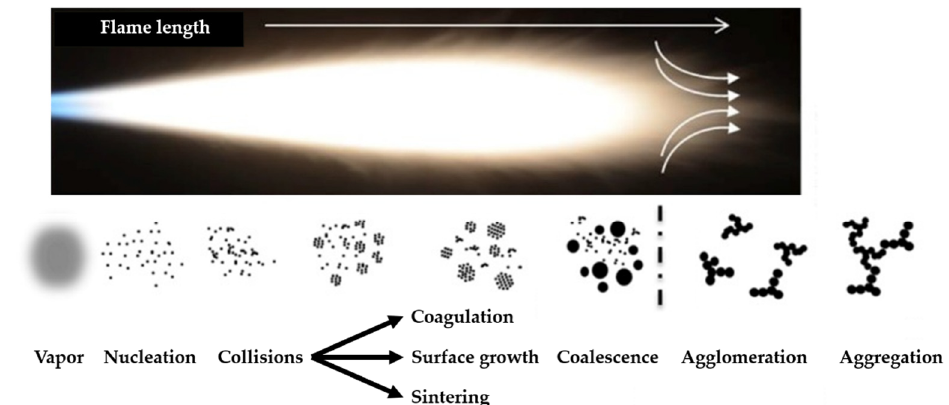
Figure 4. A common pathway of particle formation in flame synthesis processes, as the molecules pass through the flame flow field [66]. Reproduced with permission from Roller, J. et al., Journal of Power Sources; published by Elsevier, 2014.